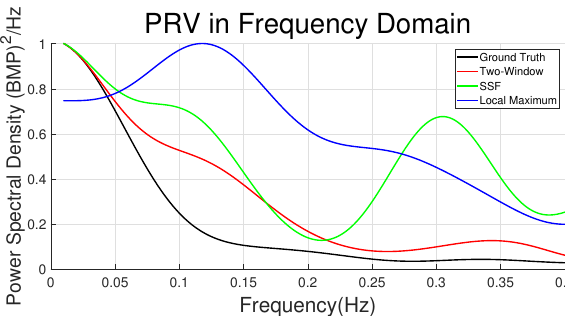
Figure 7. Comparison of PRV measurement with Local Maximum, SSF and Two-Window methods in the frequency domain. The black curve is the ground truth. The red curve is the Two-Window measured signal. The green curve is the SSF measured signal. The blue curve is the Local Maximum measured